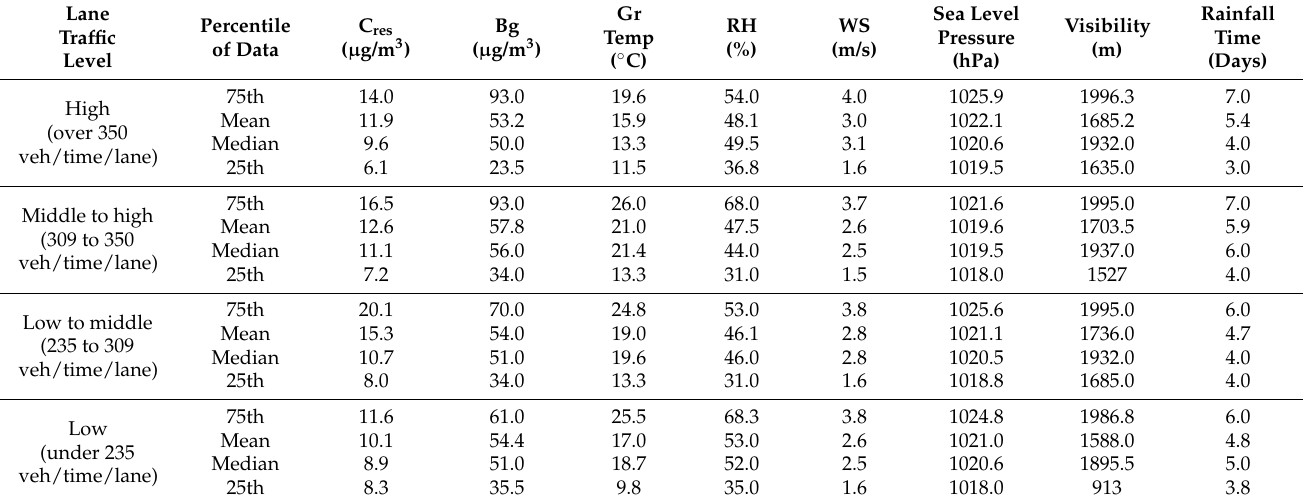
Table 6. Distribution of 25th, median, mean, and 75th percentile data by lane traffic level